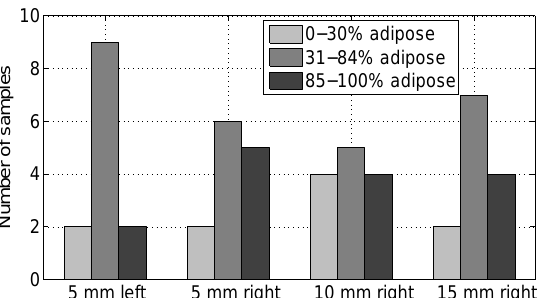
Figure 9. Histogram showing tissue composition of each sample, as determined via histological analysis. The bars show the number of cases at each measurement location (5 mm to the left and 5/10/15 mm to the right) in each of the following composition groups: 0–30% adipose, 31–84% adipose, and 85–100% adipose. Twelve of the 15 samples in the 85–100% adipose group were 100% adipose.